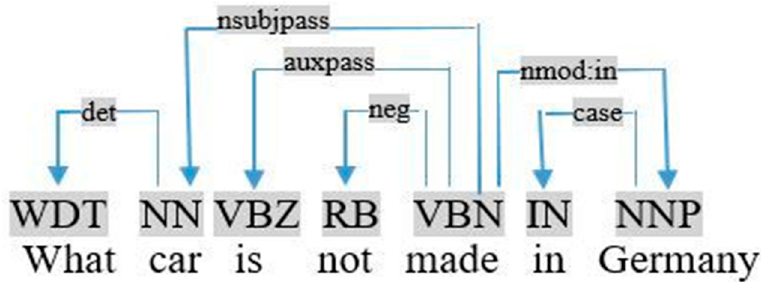
Figure 11. Graph dependency of the query «what car is not made in Germany».